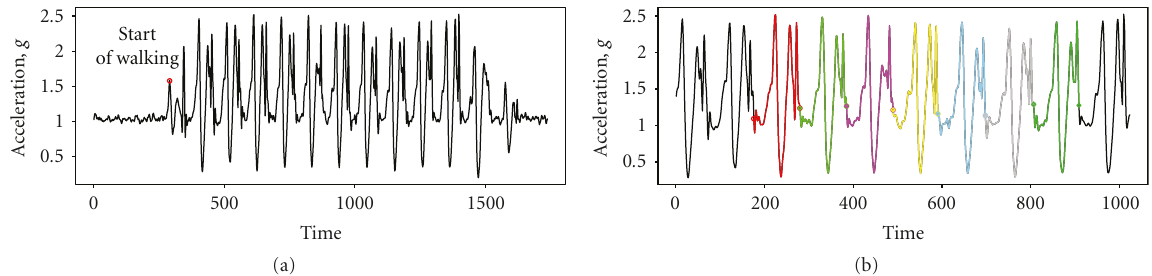
Figure 5: An example of acceleration signal from foot: (a) motion detection and (b) cycle detection.